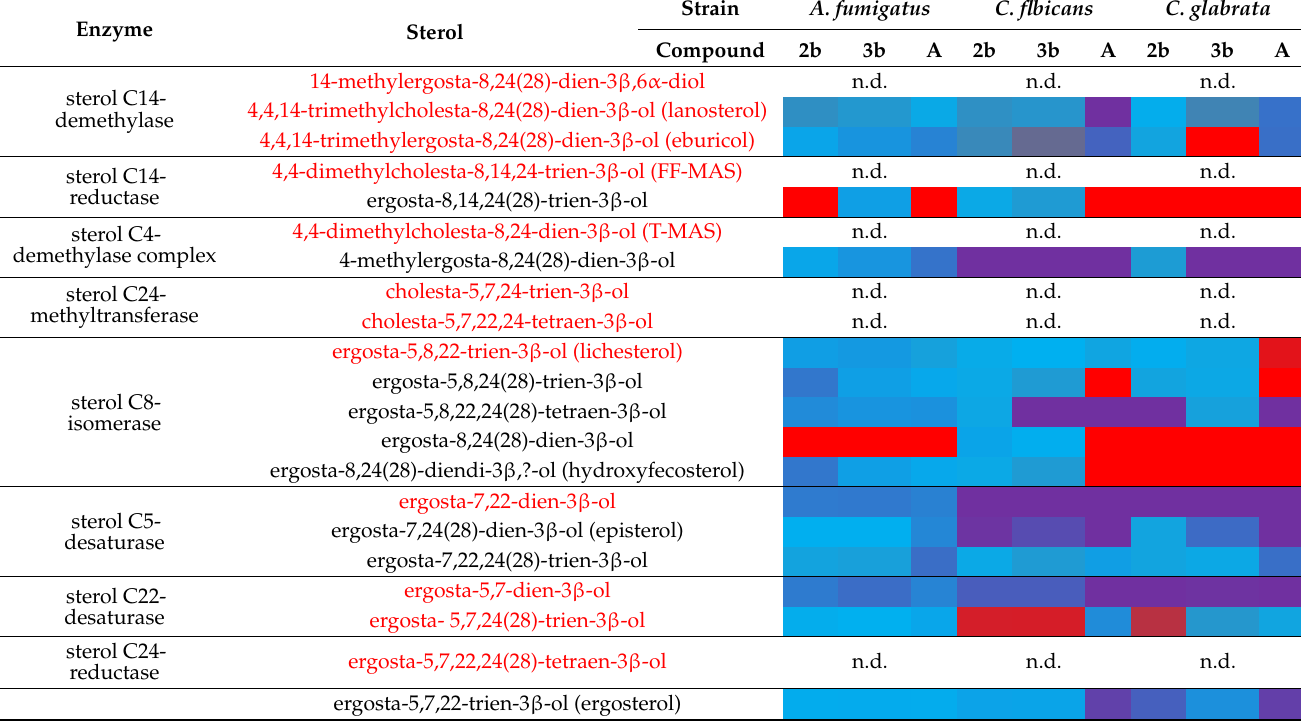
Table 4. Identification of the target enzyme(s) in ergosterol biosynthesis. Heatmap of the detected sterols. The relative sterol amount has been normalized to that of untreated samples [33]. Red: marker sterols according to Müller et al. [3]; boxes in red colour > 10-fold change, in blue colour no changes were observed, and in purple colour <0.1-fold change. A, amorolfine hydrochloride; n.d., not detected; (), trivial name; ?, unknown position of the second hydroxy group. Test concentrations: Aspergillus fumigatus : amorolfine hydrochloride (4.0 µ g/mL), 2b (3.5 µ g/mL), 3b (4 µ g/mL); Candida albicans : amorolfine (4.0 µ g/mL), 2b (3.5 µ g/mL), 3b (4.0 µ g/mL); Candida glabrata : amorolfine hydrochloride (7.5 µ g/mL), 2b (3.5 µ g/mL), 3b (4.0 µ